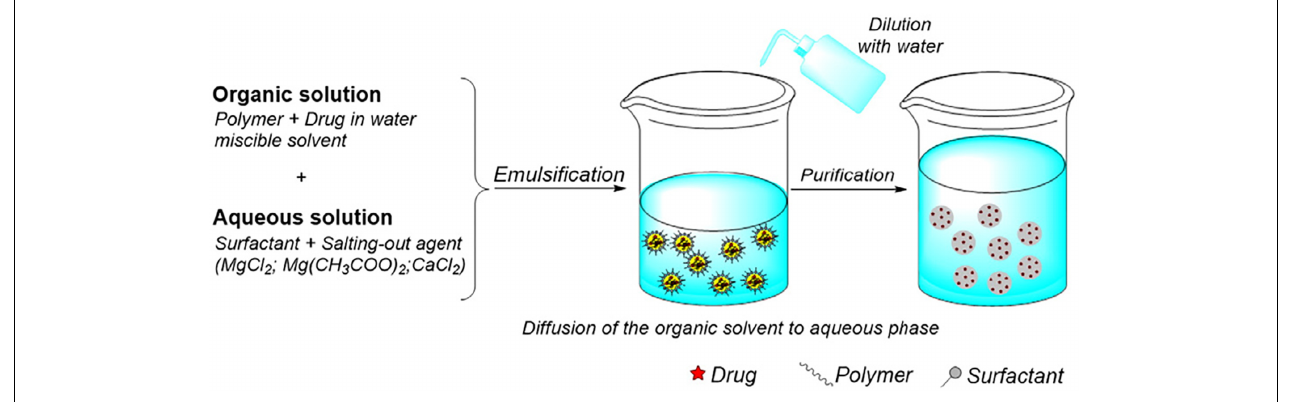
FIGURE 5 | Illustration of the salting out method of preparation, reproduced from Crucho and Barros (2017).